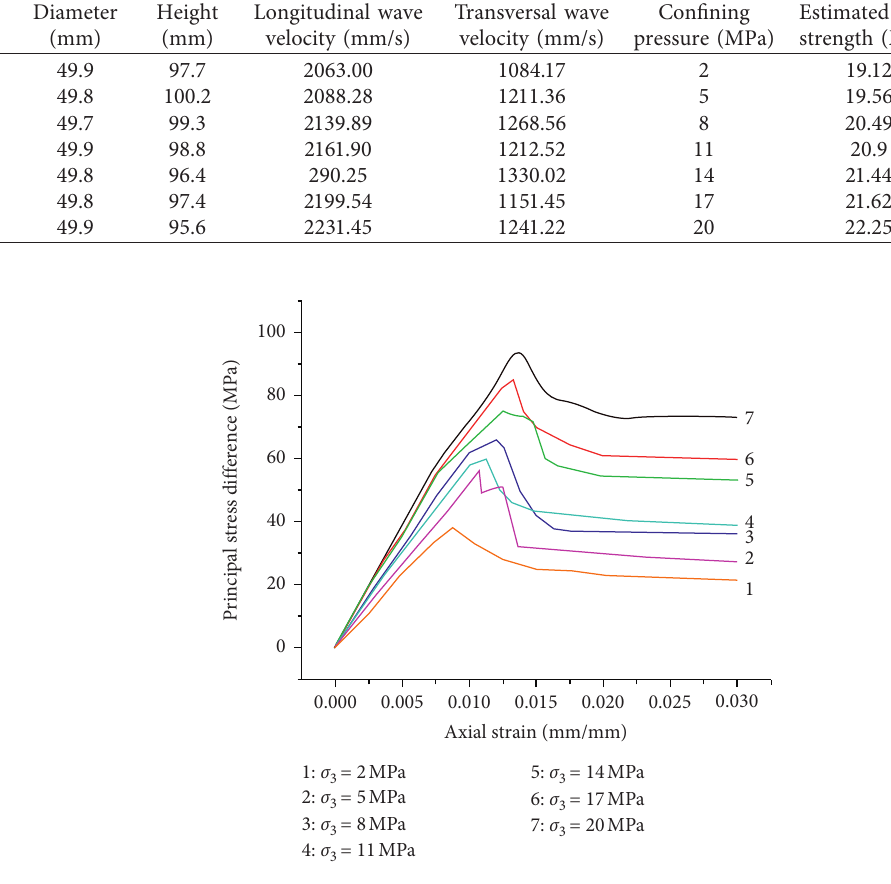
Figure 1: Curves of difference of principle stresses versus strain under different confining pressure of coal samples. Table 2: Test results of Xinhe No. 3 coal samples under different confining